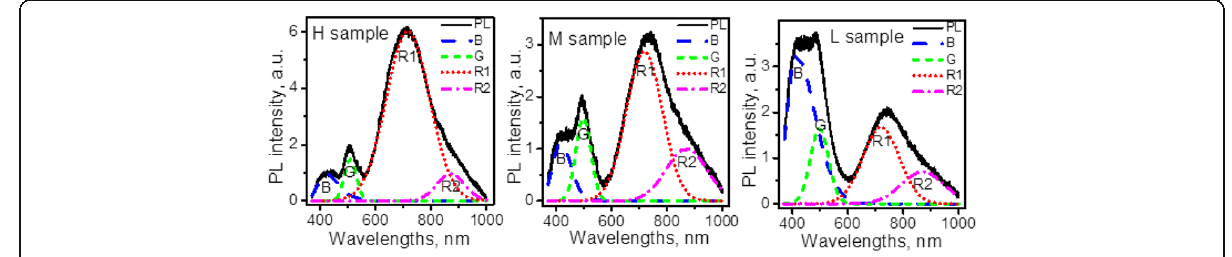
Fig. 2 Deconvolution of the PL spectra: using four components with fixed spectral positions and linewidths